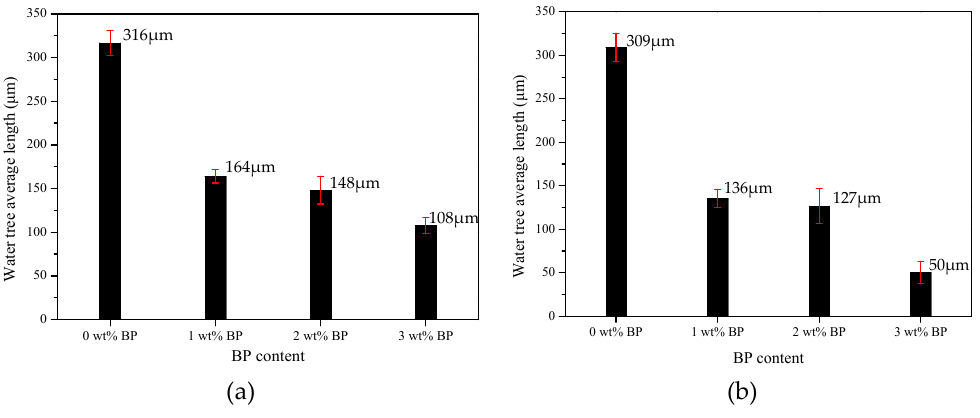
Figure 2. Water tree size ( a ) length and ( b ) width.